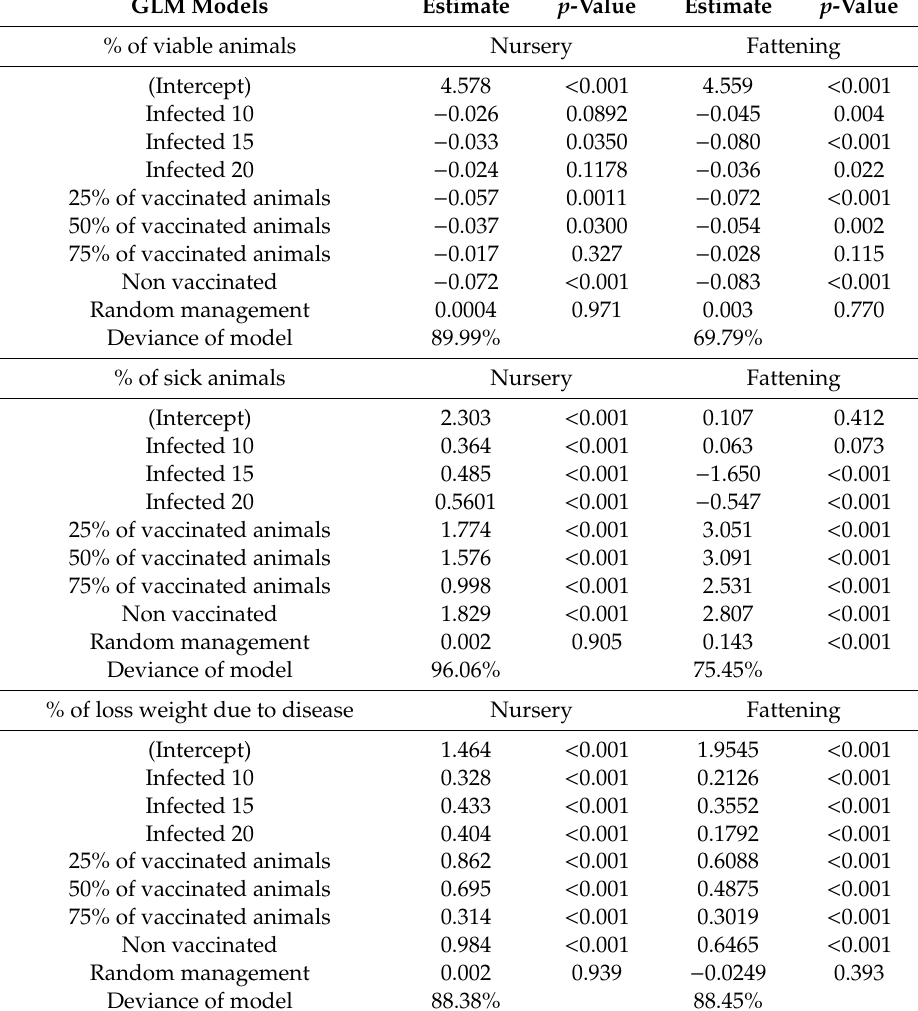
Table 2. Generalized Linear Model (GLM) results. The e ff ects of di ff erent percentages of infected and vaccinated animals and management regimes on the percentages of viable and sick animals, and of animals showing total weight loss, during the nursery and fattening phases of production. Two management regimes are compared: orderly movements, in which fattening pens are filled with piglets housed together in the nursery unit according to the identity of their mother (mother management); and random movements, where piglets are assigned to the nursery and fattening pens at random (random